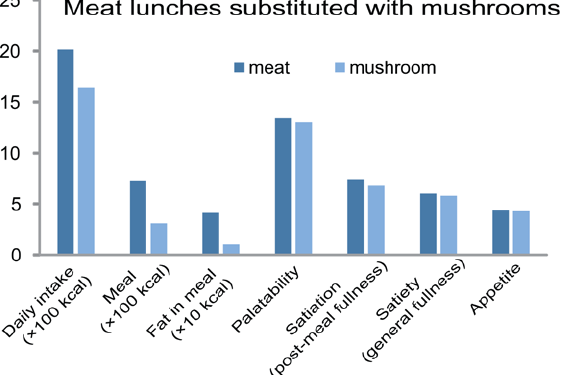
Figure 7. A mushroom-containing reduced calorie meal served over 4 days did not negatively affect